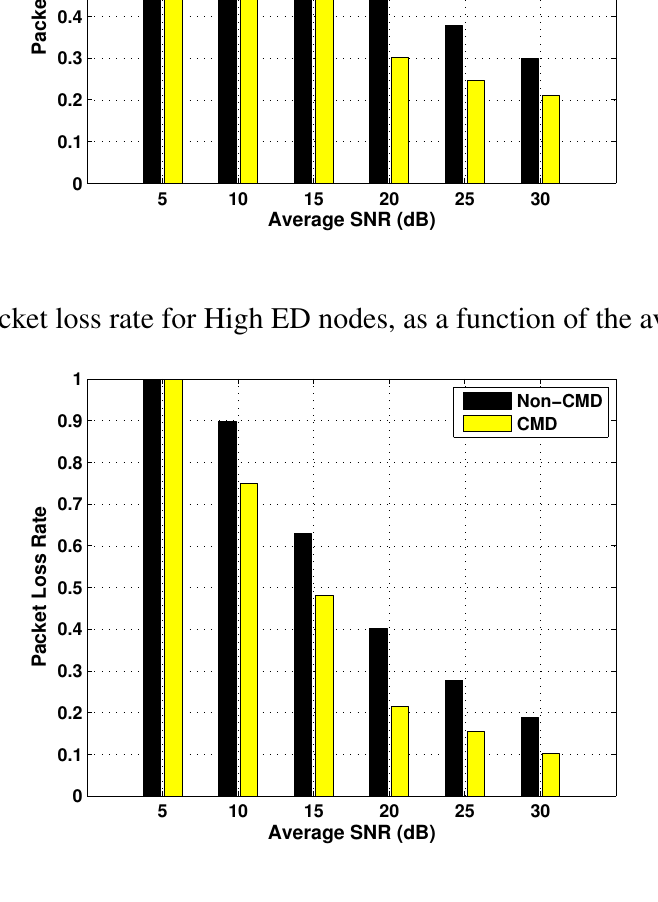
Figure 7. Packet loss rate for Critical ED nodes, as a function of the average